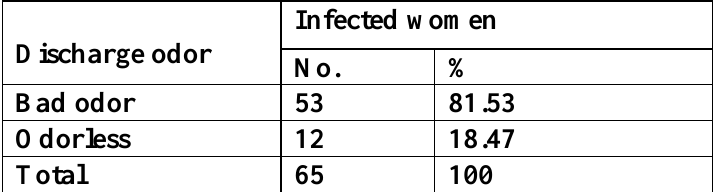
Table (3): Relation between vaginal discharge odor and Trichomoniasis infection.